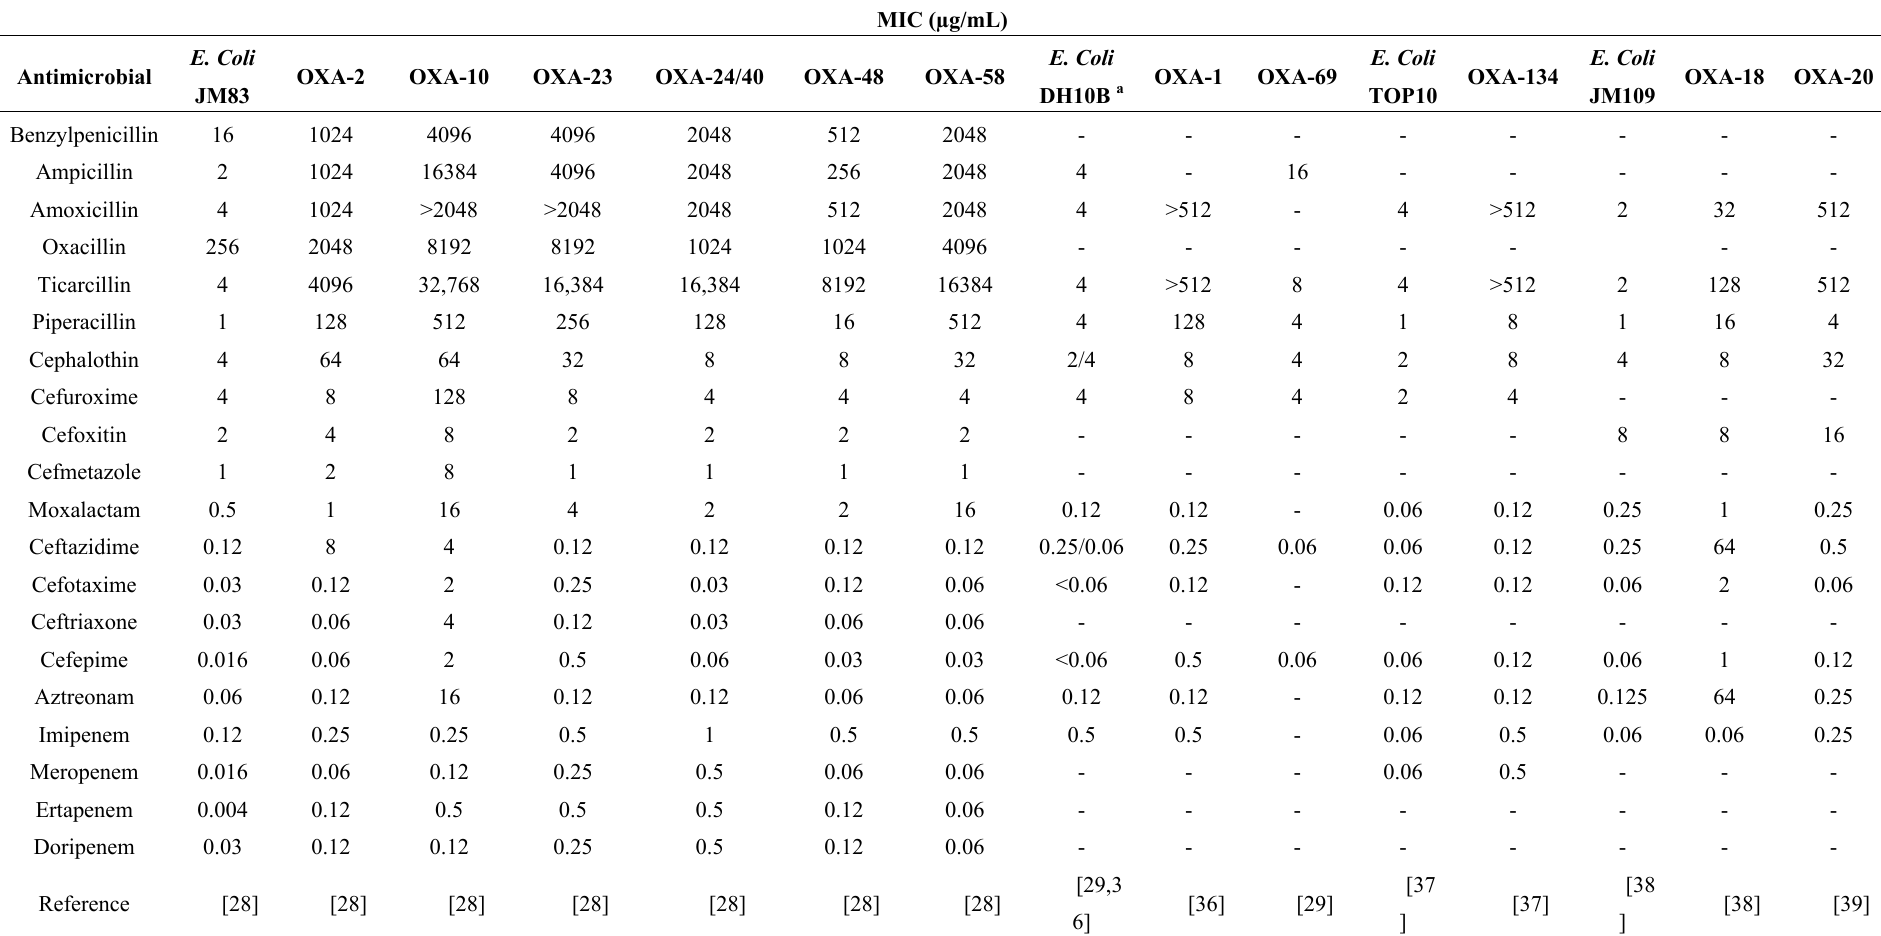
Table 2. Minimal inhibitory concentrations for selected Class D β-lactamases in E. coli